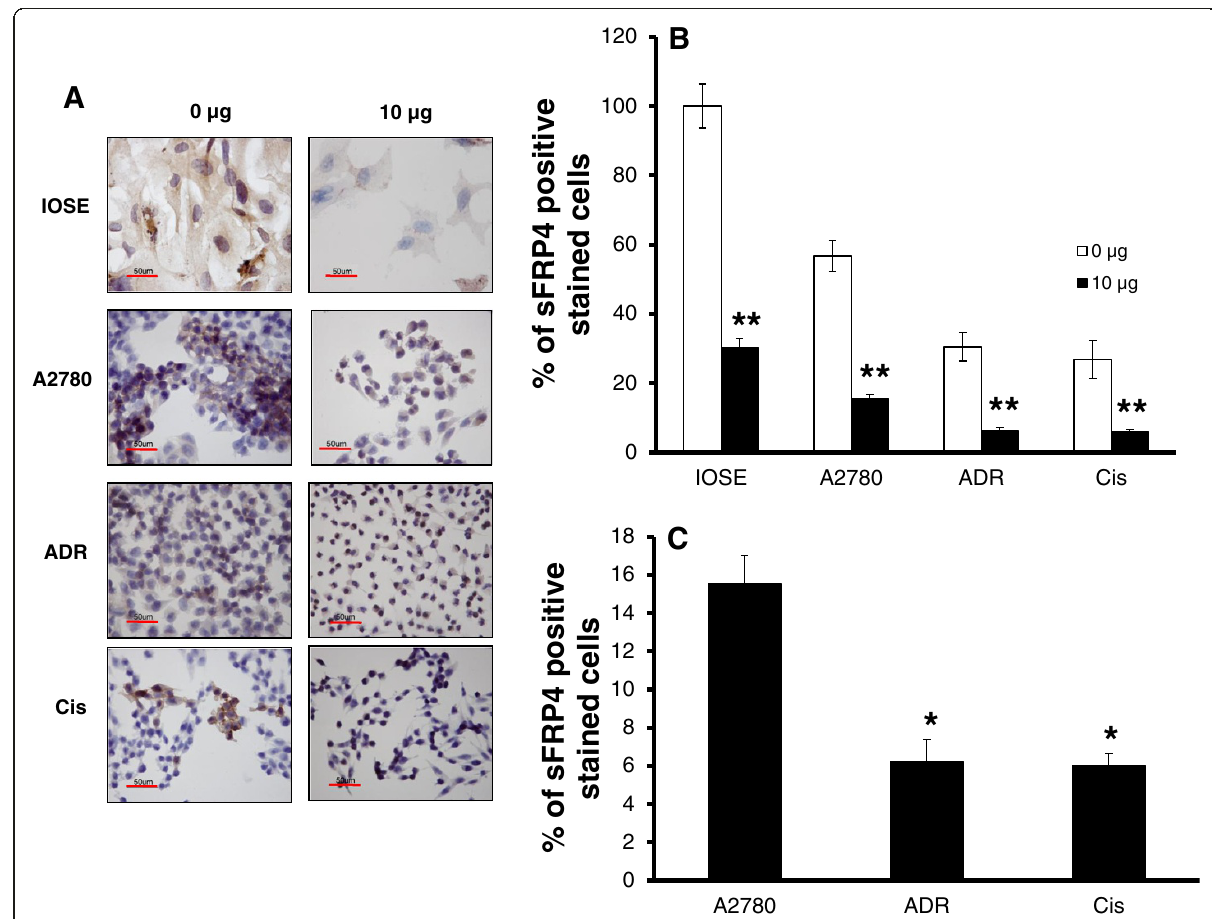
Figure 4 (A) Light microscope images (400X) of each cell line before and after Cisplatin treatment. sFRP4 protein stained brown with DAB and counterstained with haematoxylin for contrast (Scale bar = 50 μ m). ( B ) Comparison of sFRP4 protein expression between untreated and treated cells of all four cell lines. ( C ) Quantification of the proportion of cells stained positive for sFRP4 following Cisplatin treatment in chemosensitive cell line A2780 vs. Chemoresistant cell lines ADR and Cis. Values represent the mean for each group ± SEM. (* p < 0.01; ** p < 0.001 one way ANOVA and